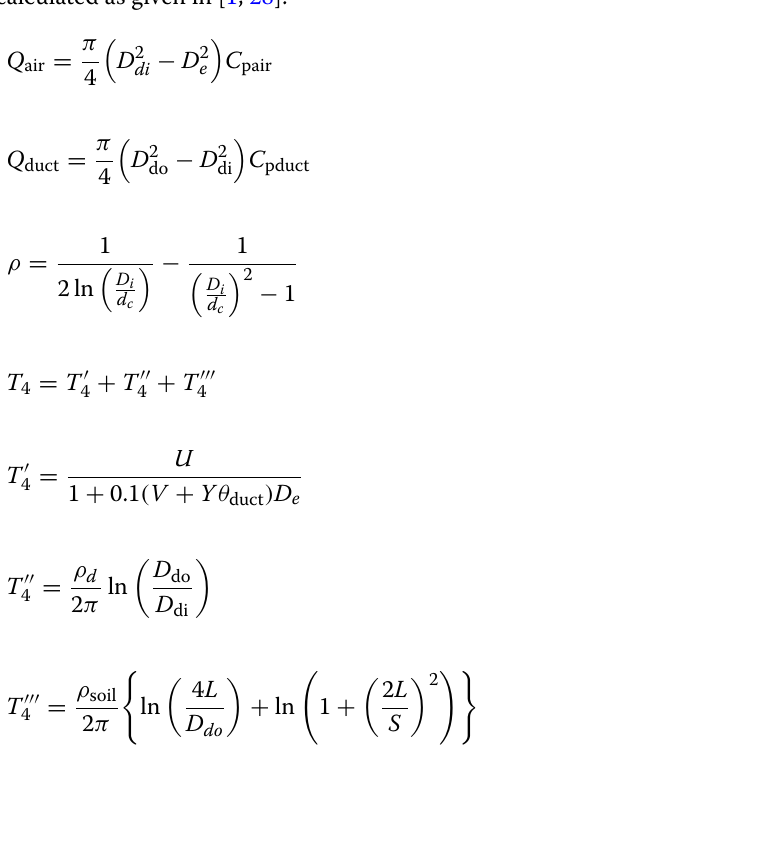
where Q air and Q duct are the thermal capacitances of air in the space between duct inner ′ surface and outer surface of cable jacket and the cable duct, respectively. T 4 is the air thermal resistance between the inner surface of the duct and the cable jacket. The ther- ′′′ T ′′ mal resistance of the soil around the duct is defined as T 4 . 4 indicates to the duct ther- mal resistance. The thermal resistances of the metallic layers are ignored. θ duct and θ air ◦ C above surrounding temperature, respectively. The are the duct and air temperatures additional thermal capacitances and resistances of cable in each part and the around soil are calculated as given in [1,